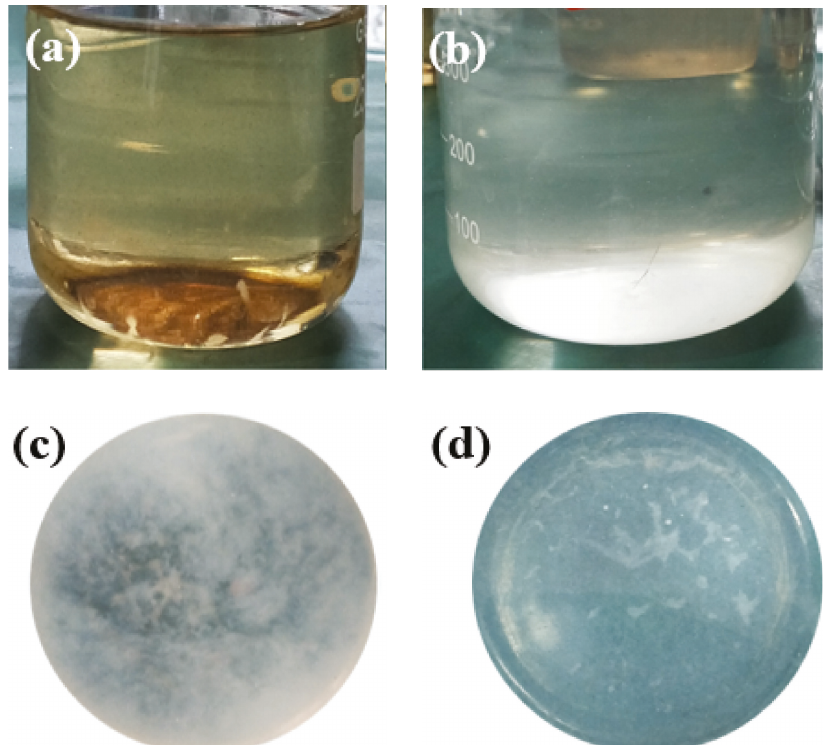
Figure 5: 500 ° C desiliconization filtrate (a), 600 ° C desiliconization filtrate (b); solution after acid treatment of desiliconization filtrate at 600 ° C (c) and solution after standing for 24h (d).